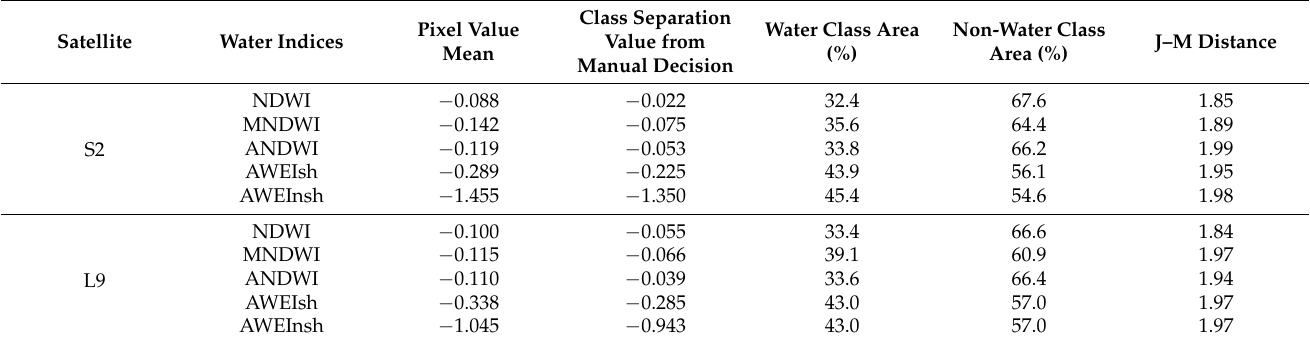
Table 3. Water and non-water class separation index values obtained from Sentinel-2 (S2) and Landsat 9 (L9) satellite imagery, estimated from manual decision analysis of the histograms. Pixel spatial resolution is 20 m for S2 and 30 m for L9.